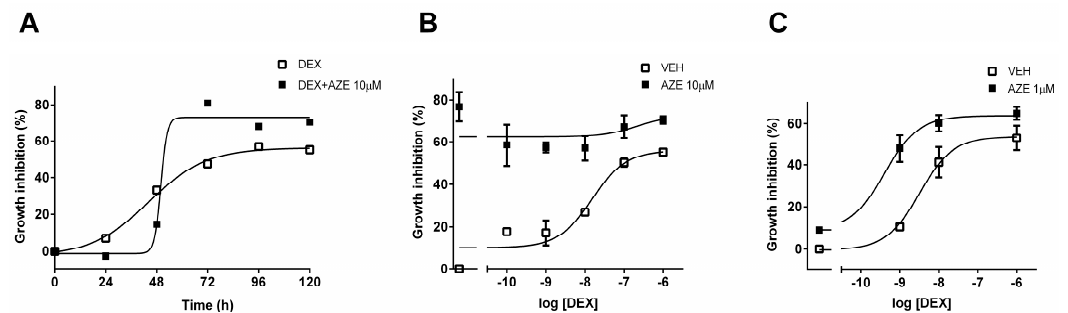
Figure 6. Azelastine potentiates dexamethasone-induced osteoblastic cell growth inhibition. ( A ) MC3T3-E1 pre-osteoblastic cells differentiated to osteoblasts were exposed to 10 µ M azelastine (AZE) and treated with 1 nM dexamethasone (DEX) for different time periods. Maximal growth inhibition was achieved at 96 h. ( B ) Cells were treated with 10 µ M azelastine (AZE) and then subjected to different concentrations of dexamethasone (DEX) for 96 h. ( C ) Cells were treated with 1 µ M